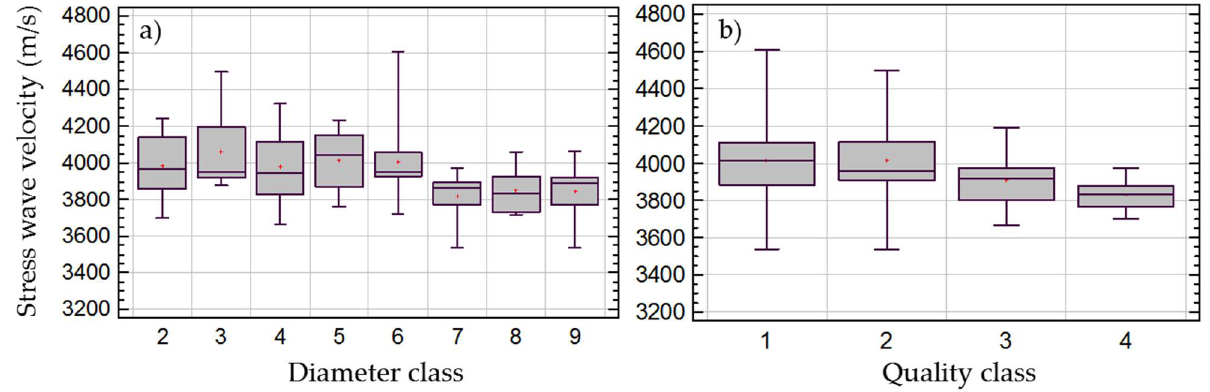
Figure 10. Distribution and interdependence between stress wave velocity and ( a ) diameter class,